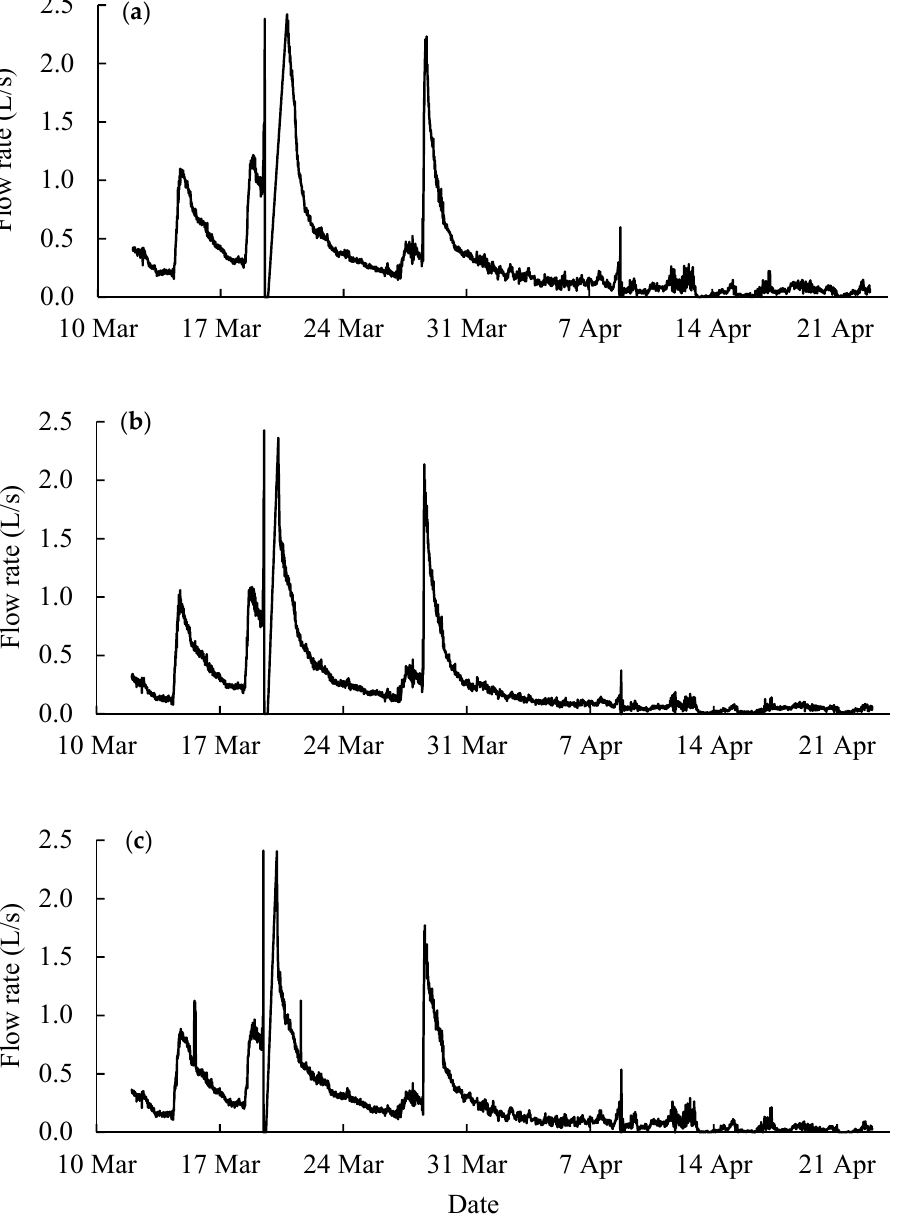
Figure 8. Water flow rate in ( a ) tile line #4, ( b ) tile line #7 and ( c ) tile line #46 recorded by the Agridrain system in 2020. Please note that the flows between 19–20 March exceeded 2.47 L/s, which is the detection limit of the Agridrain structure.